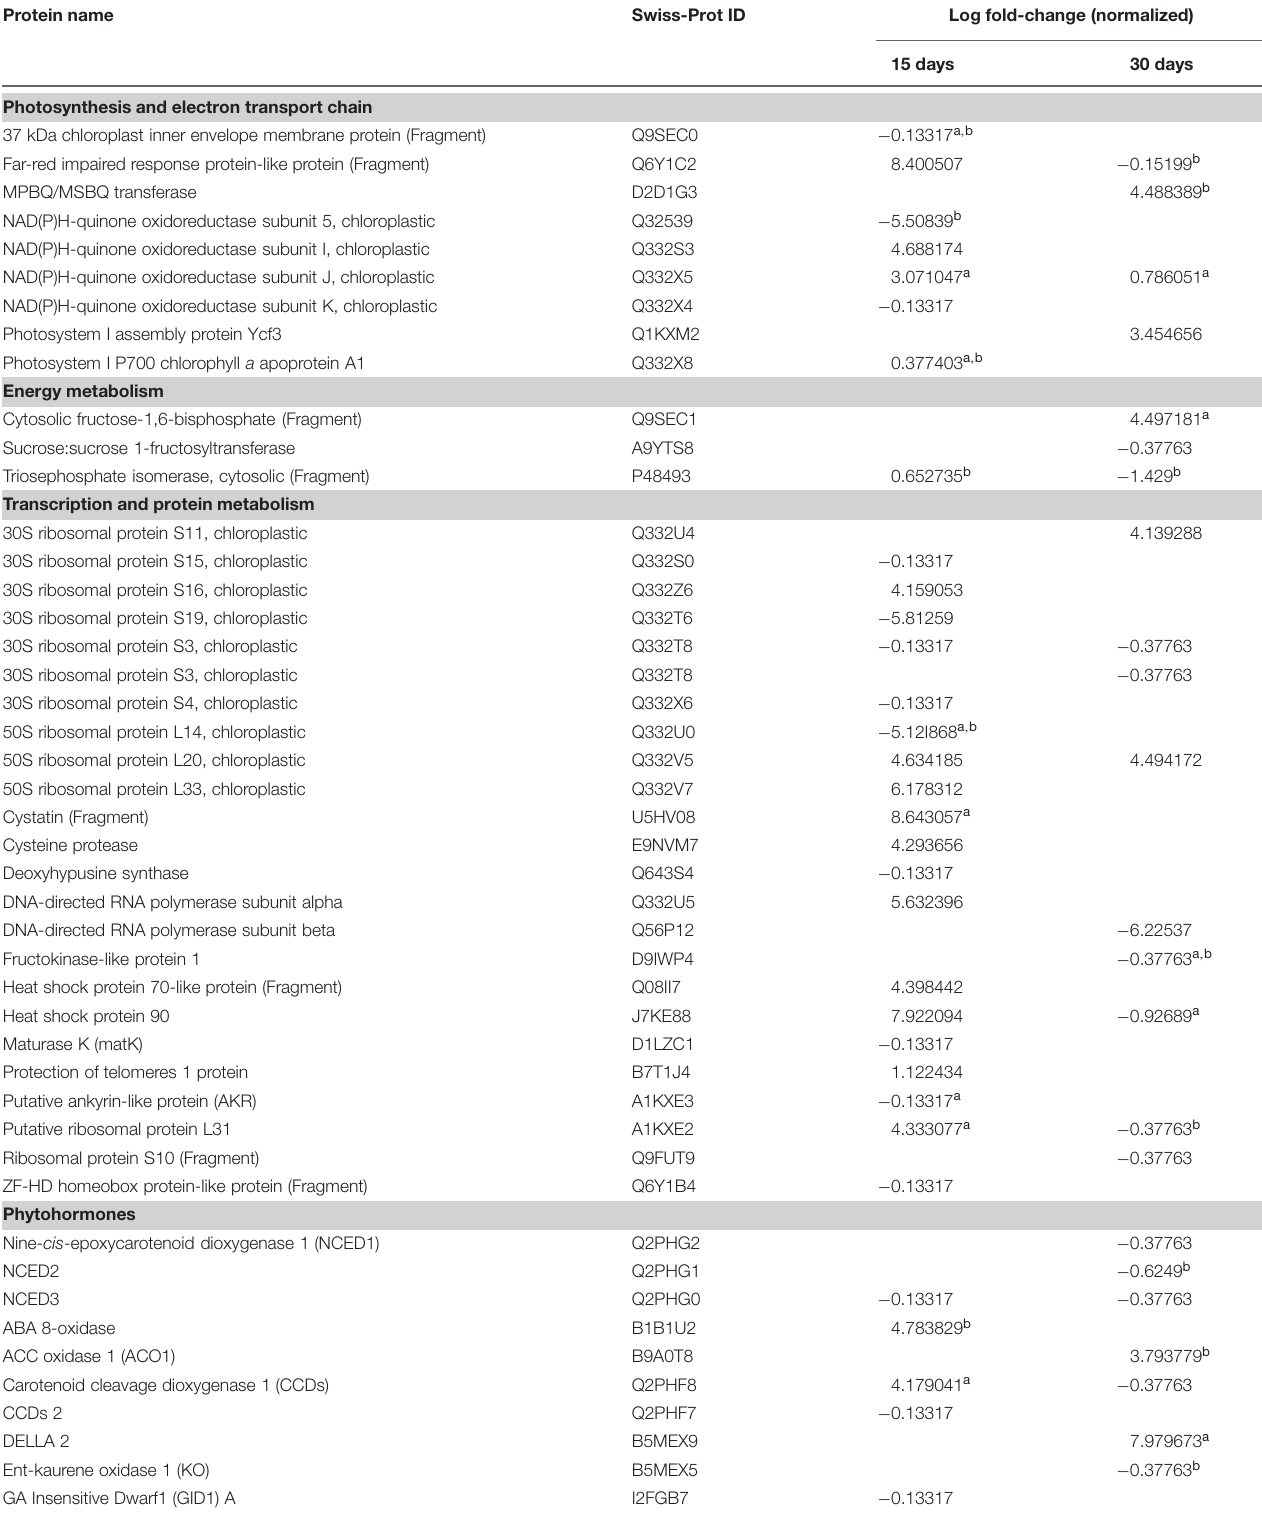
TABLE 1 | Proteins resulted down-accumulated and up-accumulated in lettuce leaf after 15 and 30 days under zinc stress conditions, considering a fold change above three on log 2 normalized